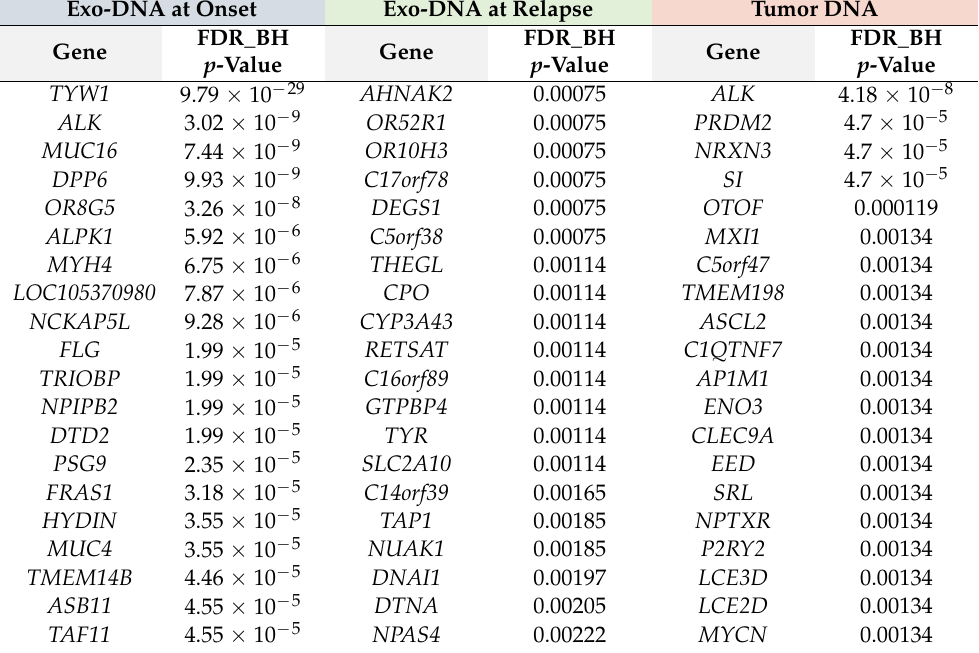
Figure 8. Mutation types in exo-DNA and in tumor DNA. Table 4. The 20 most frequently mutated genes in exo-DNA and in tumor DNA. Exo-DNA at Onset Exo-DNA at Relapse Tumor